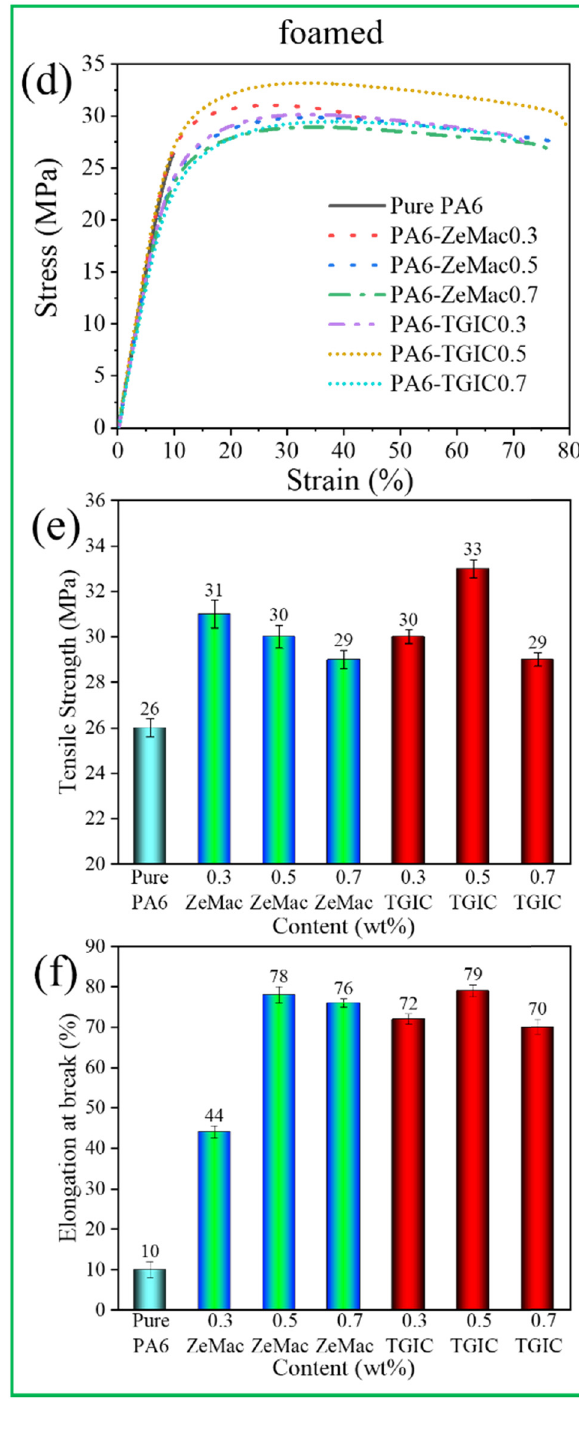
Figure 8: Tensile mechanical properties: ( a and d ) stress – strain curves, ( b and e ) tensile strength, and ( c and f ) elongation at